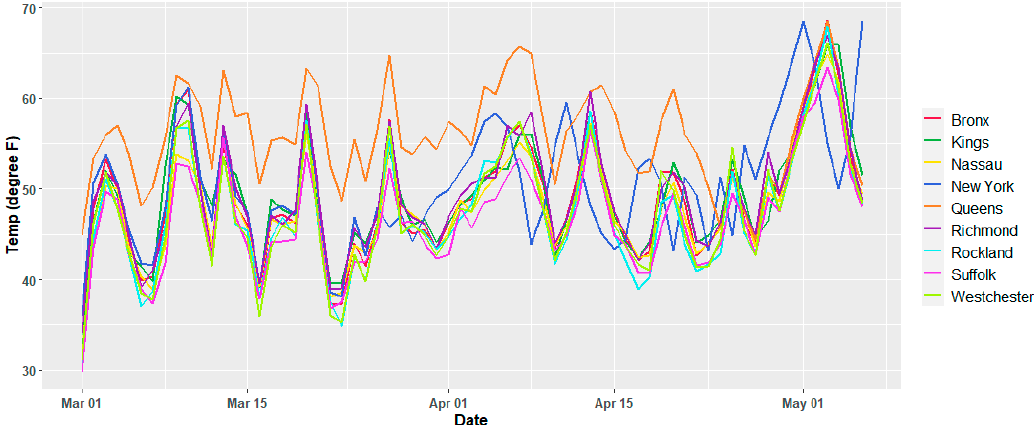
Figure 3. Variation of daily average temperature for individual counties.